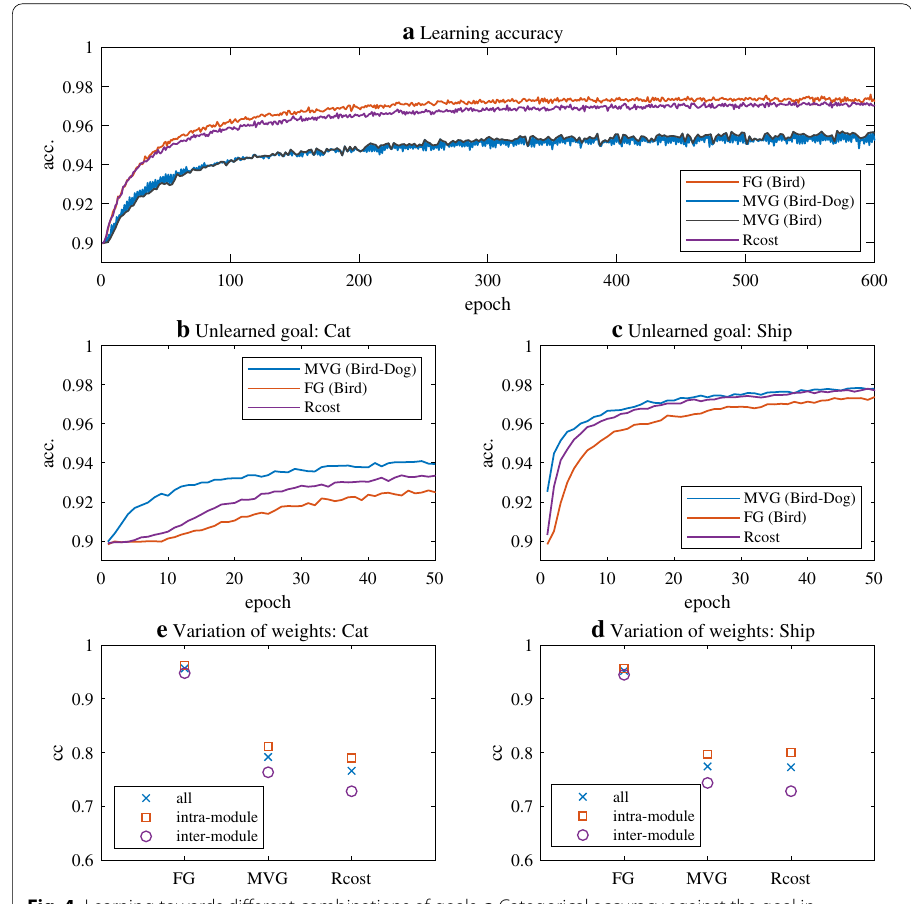
Fig. 4 Learning towards different combinations of goals. a Categorical accuracy against the goal in learning. Blue indicates the MVG of Bird and Dog. Black connects the epochs involved in learning Bird in the MVG. Red indicates the FG of Bird. Purple indicates Rcost. b , c Categorical accuracy against unlearned goals Cat and Ship. The weights of the initial neural network are from the last epoch of ( a ). e , d Pearson’s correlation coefficient (cc) against before and after learning the unlearned goals Cat and Ship. The cc of the filter elements of the initial neural network and the last neural network in ( b , c ) is shown. Blue indicates the cc values of all the filter elements. Red indicates the cc values of elements in the filter corresponding to intra-module links. Purple indicates the cc values of elements in the filter corresponding to inter-module